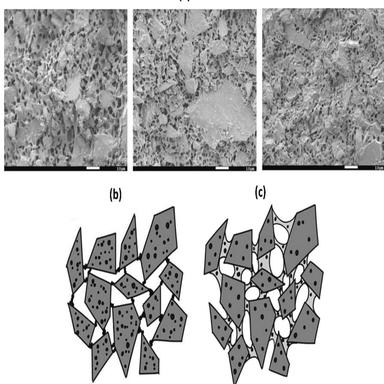
(a) Microstructure of M3 by cryo-SEM (1000× magnification) at 5 min; 20 min and 60 min. Schematic diagram of microstructure of early-age reactions using cryo-SEM for (b) hydroxide-based alkali-activated slag (AAS) paste and (c) silicate-based AAS paste. Image reproduced from.